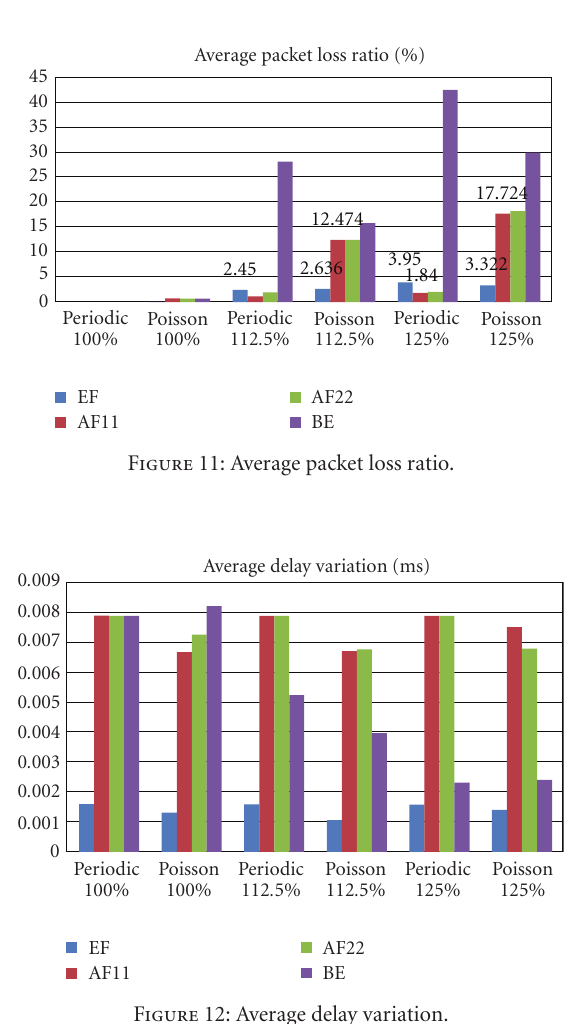
Figure 14: Average packet loss